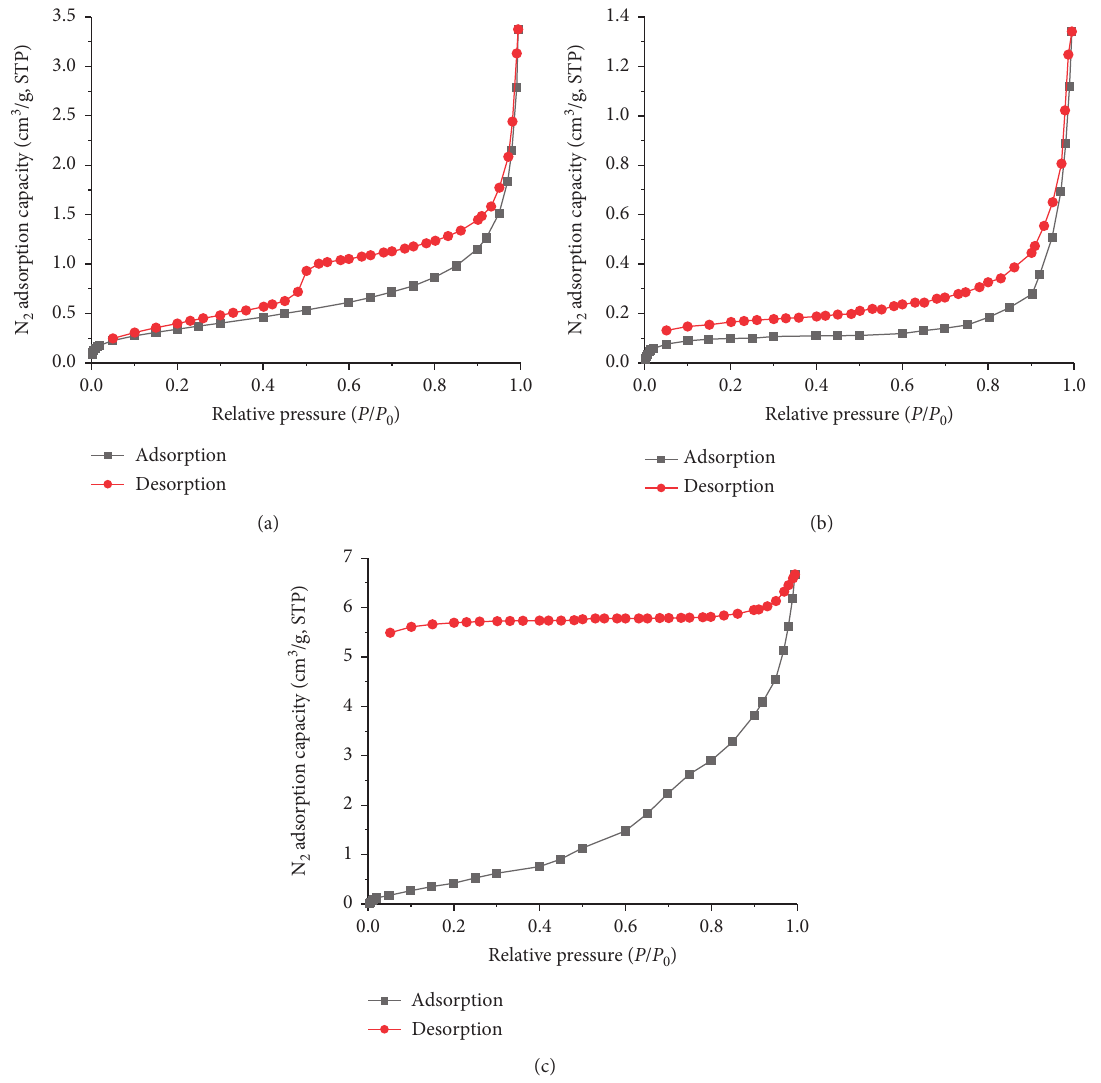
Figure 4: LP-N 2 GA isotherms for three coal samples. (a) Dashucun. (b) Sihe. (c) Yuwu.